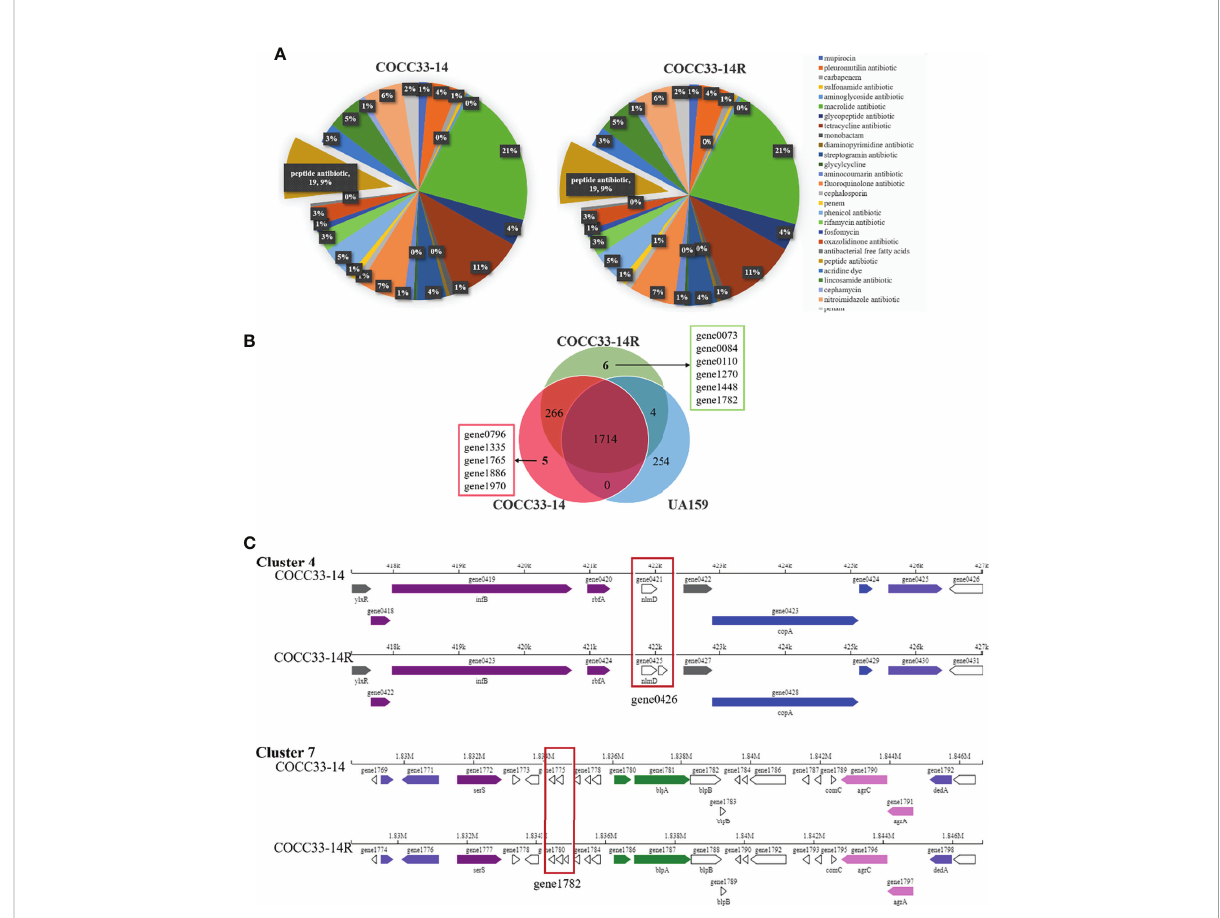
FIGURE 4 Analysis of genome of COCC33-14R. (A) CARD annotations and prediction of probable resistant genes. (B) Differential genes between COCC33- 14R and COCC33-14. (C) Comparison of linear plot of secondary metabolite gene Cluster 4 and Cluster